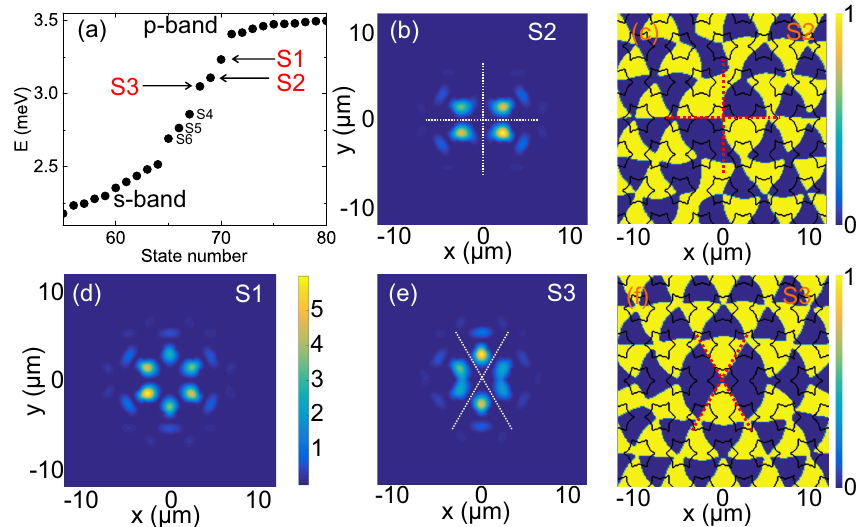
Figure 5: (a) Calculated eigenvalues of the honeycomb lattice subject to a local po- tential of 3 meV in the central hexagonal cluster. Only the region around the gap between s- and p-bands is shown. (b), (d), (e) Calculated squared absolute values of the eigenfunctions corresponding to the S2, S1, and S3 gap states in horizontal polarisation (identical shapes are found for the vertically polarised modes). (c), (f) Phase of the eigenfunctions corresponding to S2 and S3. The phase is displayed in units of π